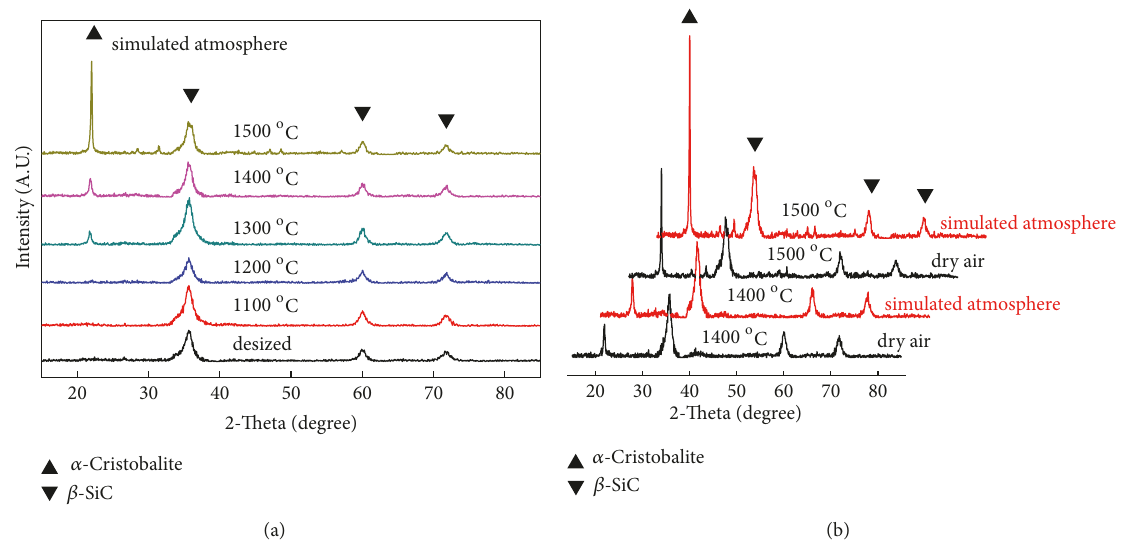
Figure 3: The XRD patterns of KD-S fibres after annealing for 1 h. (a) Under simulated atmosphere. (b) Under simulated atmosphere and under dry air.